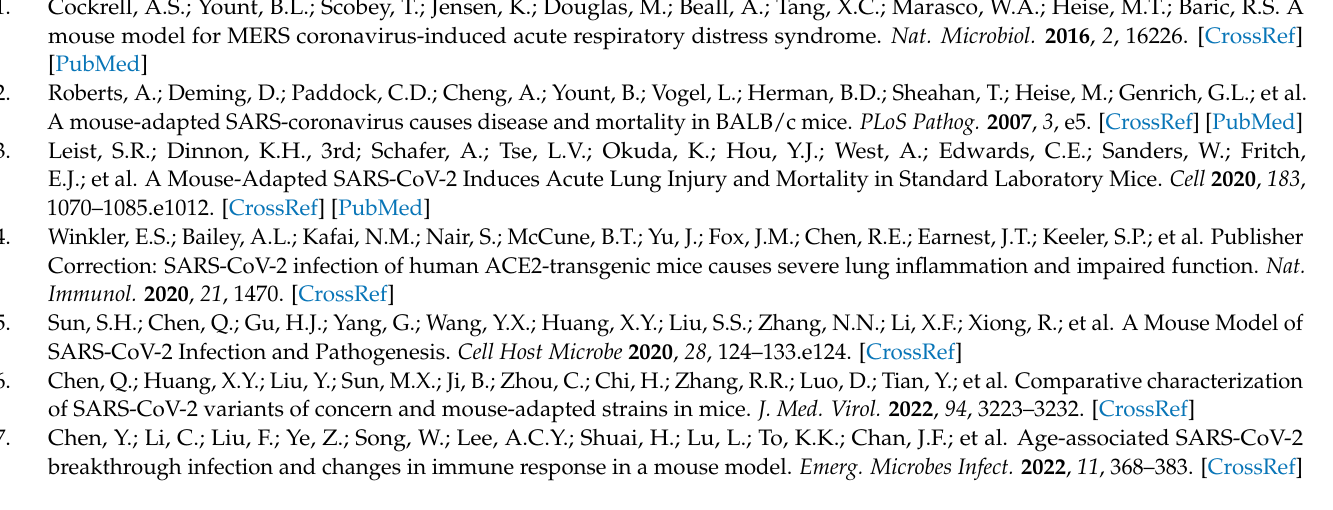
monitis (day 7). Figure S5: Representative histology of comorbidities in 2 year-old mice. Images are from mock-infected control mice. (A) Amyloidosis involving lung, (B) Amyloidosis involving heart, (C) Amyloidosis involving duodenum, (D) Lymphoid hyperplasia in spleen, (E) Lymphoid hyperpla- sia in liver, (F) Adenoma in lung, and (G) Hyaline glomerulopathy. Figure S6: Representative tissue pathologies as noted from H&E-stained tissue sections of SCID mice following infection with R2G. Shown are representative images of bronchial cell death at day 2, peribronchovascular inflammation at day 7, negligible interstitial pneumonitis at day 7, endovascular inflammation at day 4, and negli- gible pulmonary edema at day 7. Figure S7: (A,B) Scree plots showing contribution of genes to PC1 and PC2, respectively. Dashed line shows average contribution of all genes. (C) Heat map showing Tukey-adjusted statistical significance with red showing a positive correlation and blue showing a negative correlation. Figure S8: Baseline box plots for mock treated animals. Figure S9: Scoring metric for RNA-ISH. Figure S10: Smoothed line plots for single gene expression data from 10 wk-, 20 wk-, and 2 yr-old mice for treatment and timepoint. Lines show smoothed average of tethered counts. Circles show individual animals. Grey shading shows 95% confidence